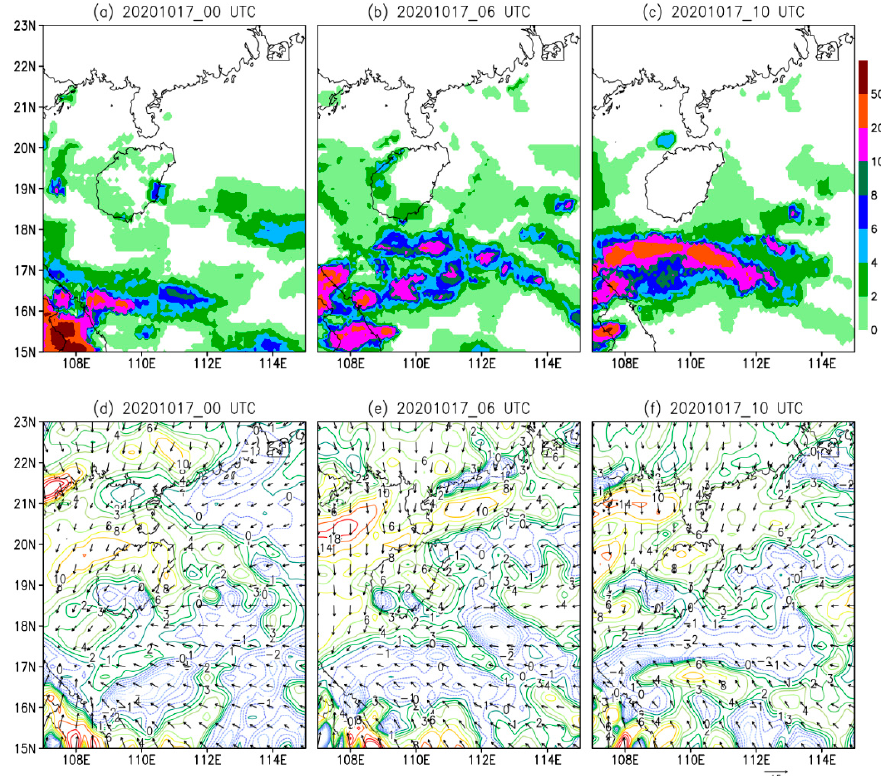
Figure 9. ( a – c ): Hourly precipitation (units: mm) using the CMORPH data set, and ( d – f ) Q vS (contours at interval of 1 × 10 − 8 g · hPa − 1 · cm − 2 · s − 1 ) superimposed with divergent wind vectors (units: m · s − 1 ) at 925 hPa at 0000, 0600 and 1000 UTC 17 October